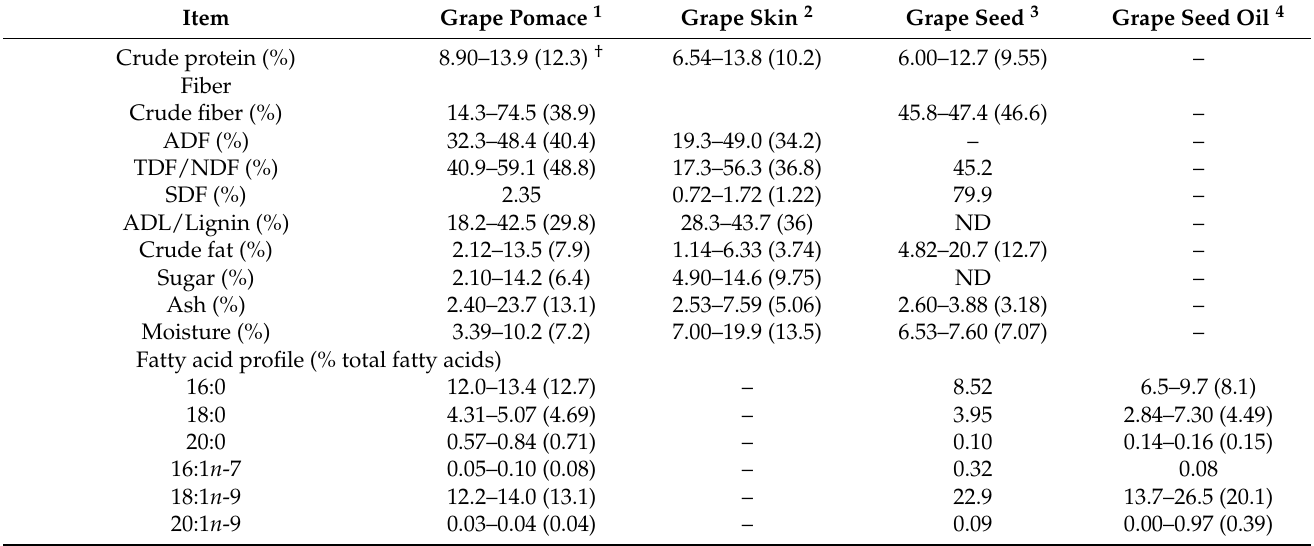
Table 1. Chemical and nutritional composition of the main grape by-products (values are expressed on a dry weight basis,